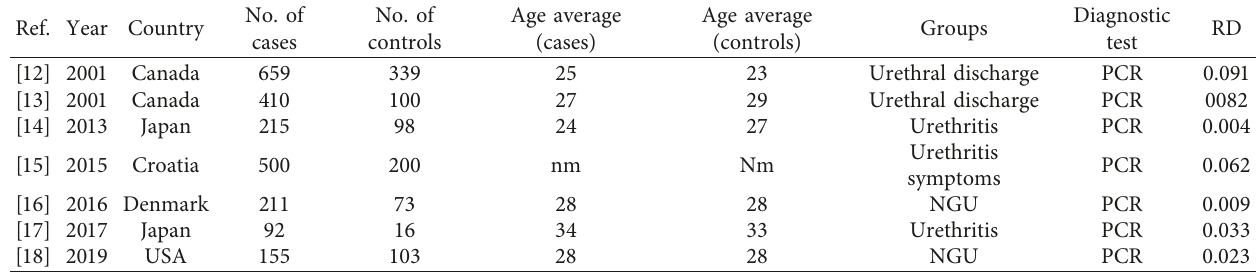
Table 1: Baseline characteristics of the included studies in the systematic review and meta-analysis of the relationship between T. vaginalis infection and male urethritis patients.